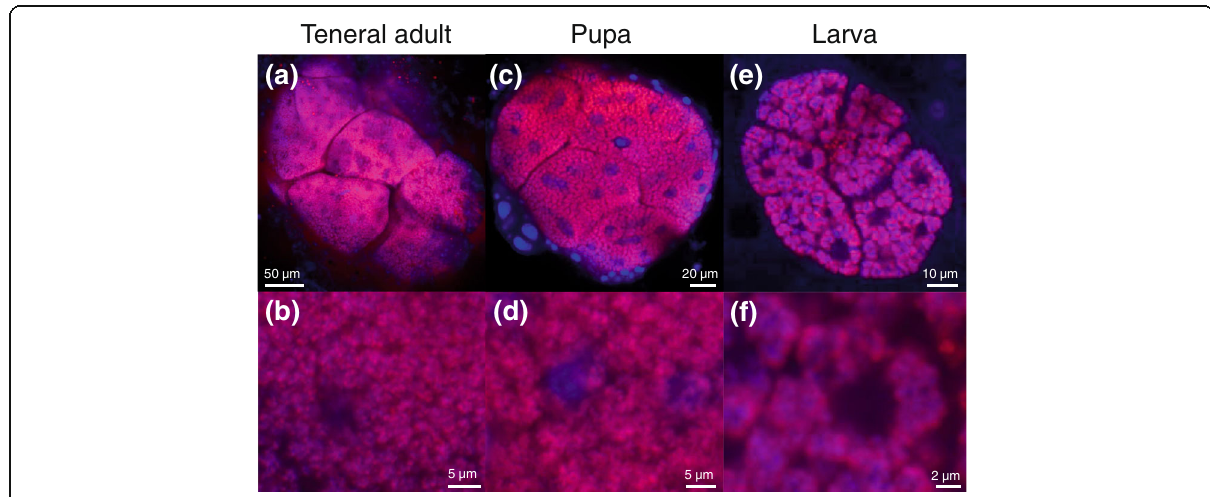
Fig. 4 Laser confocal fluorescence microscopic images of bacteriomes and symbiotic bacteria of R. dominica . a, b Teneral adult. c, d Pupa. e, f Larva. a, c, e Images of dissected bacteriomes. b, d, f Enlarged images of bacteriocytes whose cytoplasm is full of symbiotic bacteria. Symbiont 16S rRNA is visualized by fluorescence in situ hybridization in red. DNA is counterstained in